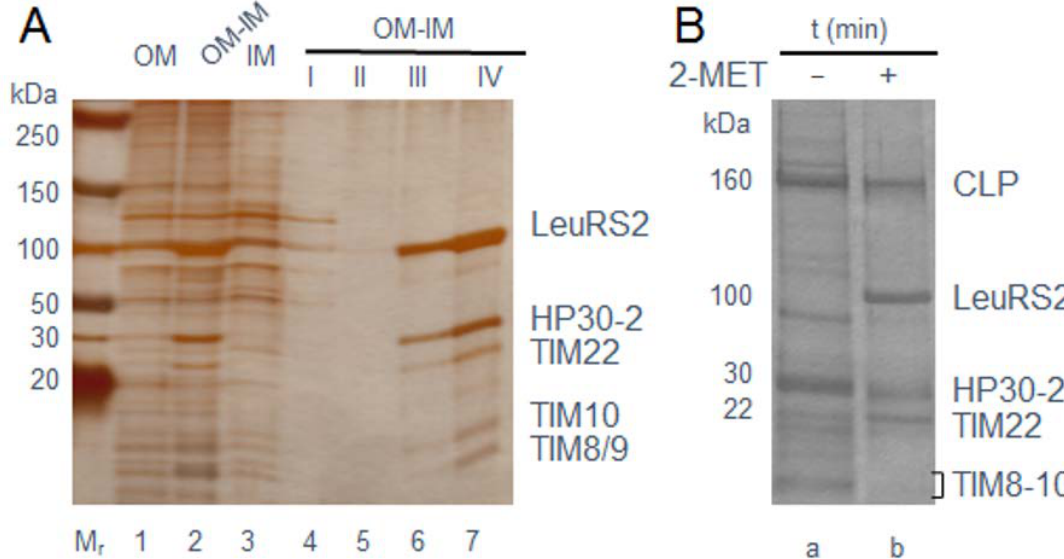
Figure 2. Identification of proteins interacting with LeuRS2 during its import into mitochondria. ( A ) Detection of LeuRS2- (His) 6 in translocation intermediates produced at 8 ◦ C during an in vitro-uptake reaction with isolated mitochondria. Lanes 1–3, patterns of proteins found in outer membranes (OM), inner membranes (IM) and OM–IM fractions obtained in the presence of imported LeuRS2-(His) 6 after sucrose density gradient fractionation of ruptured mitochondria. Fractions I, II, III and IV (Lanes 4–7) represent the different washing and elution fractions of the detergent-solubilized OM–IM fraction containing LeuRS2-(His) 6 during affinity purification on Ni-NTA agarose. Among the co-purifying proteins are HP30–2, TIM22 as well as TIM8/9 and TIM10. Positions of molecular mass standards (M r ) are indicated to the left. ( B ) Co-isolation of DTNB-activated LeuRS2-(His) 6 with HP30-2, TIM22, TIM8/9 and TIM10 as well as other, unidentified bands in OM–IM fractions ( − 2-MET, Lane a) and cleavage of the established higher molecular mass crosslink product (CLP) of ≈ 160 kDa into LeuRS2-(His) 6 , HP30-2 and TIM22 by 2-mercaptoethanol (+ 2-MET, Lane